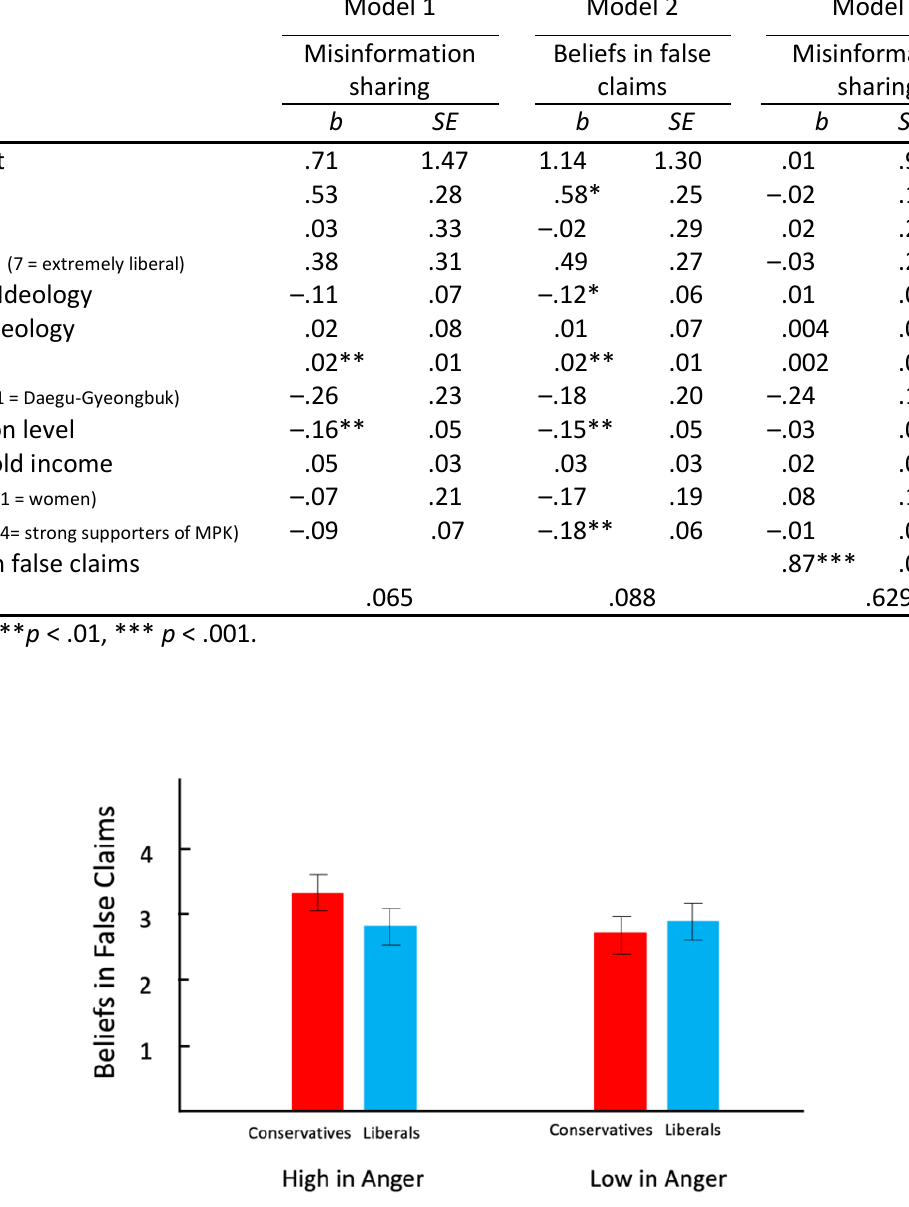
Figure 1. The interaction effect of anger and political ideology on beliefs in false claims about COVID-19. This cognitive mechanism behind misinformation sharing is presented in Figure 2. This indirect relationship is further confirmed with a bootstrap re-sampling analysis. 14 For the analyses, we used Hayes’ (2017) PROCESSS macro and computed the 95% bias-corrected confidence intervals based on 10,000